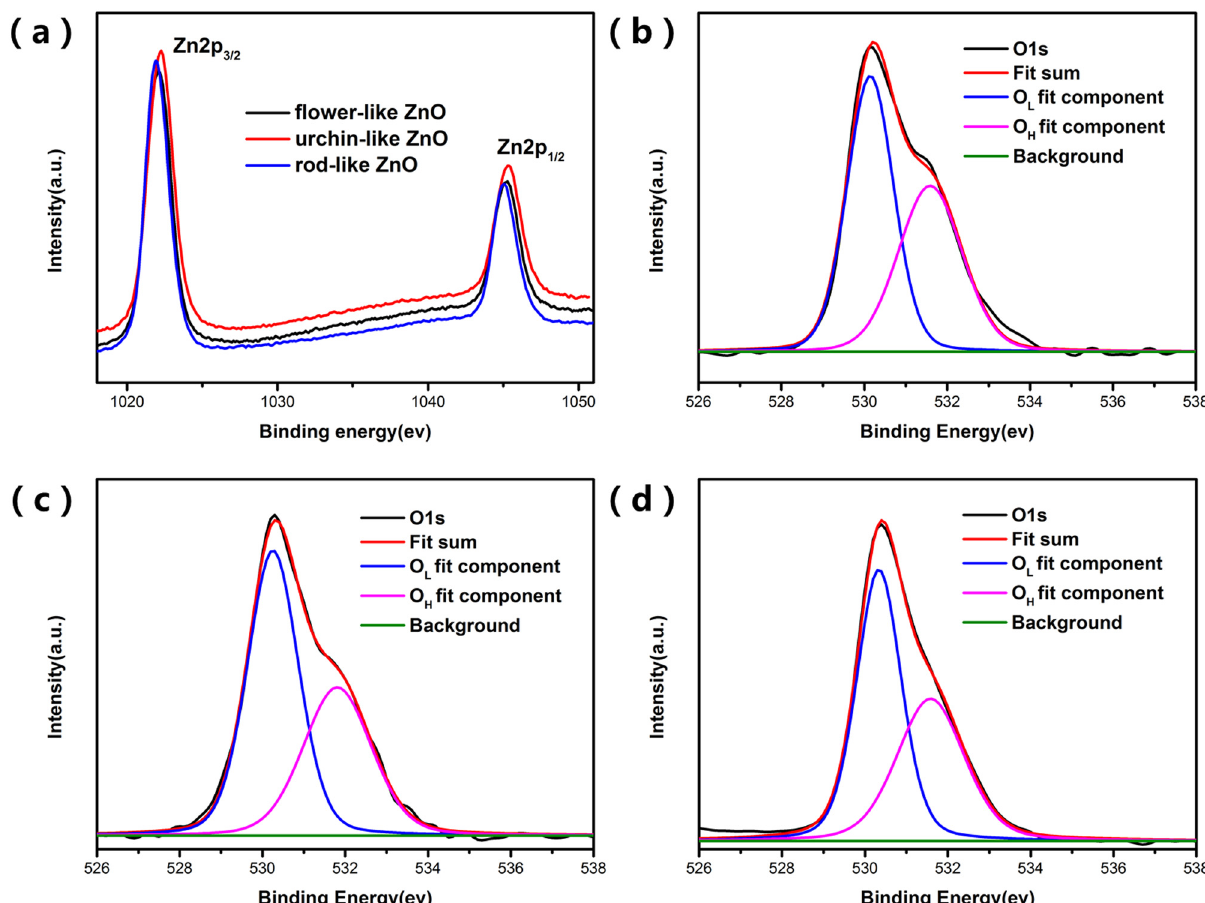
Figure 8: XPS analysis of samples showing ( a ) Zn 2p, ( b – d ) O 1s spectra of fl ower - like ZnO, urchin - like ZnO, and rod - like